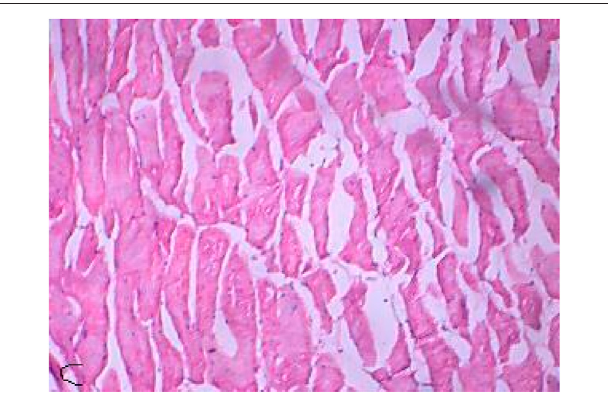
FIGURE 6 | Control gills showing primary and secondary lamellae.